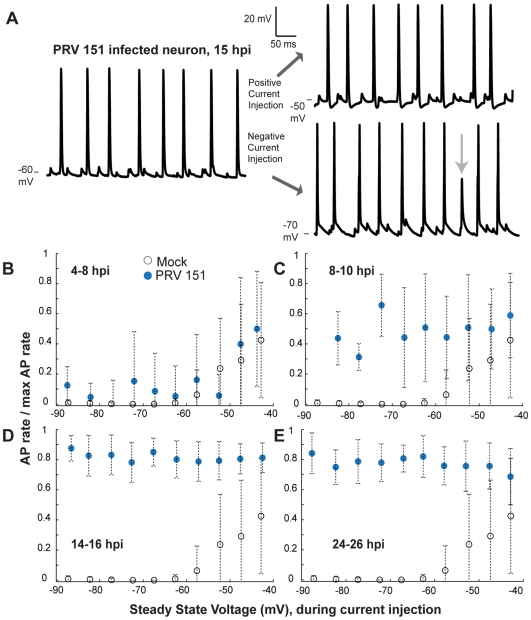
Despite large cell body current injections, elevated AP rates remain relatively unaffected.(A) Traces from a single PRV 151 infected neuron at 15 hpi. Left, voltage trace during no current injection, right, voltage trace during positive (top) and negative (bottom) current injections. Voltage levels indicated at the lower edge of each trace. (B–E) Relationship between steady state voltage and AP firing rates during current injections. The total number of APs during a given voltage bin (5 mV) was divided by the maximum AP rate for that cell (max rate during any injection −0.15 to 0.14 nA). Ratios were averaged and plotted against steady state voltage. Note relatively unchanging AP rates of infected neurons as infection progressed. Mock n = 24, 4–8 hpi PRV 151 n = 9, 8–10 hpi n = 7, 14–16 hpi n = 15, 24–26 hpi n = 7.